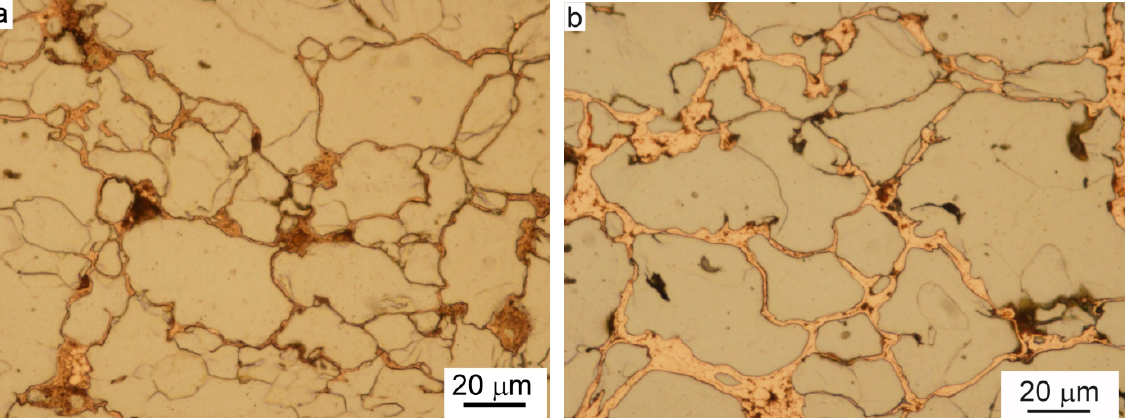
Figure 2. Cross-sections of typical copper-coated iron particles. The content of copper in presented powder is 8 wt.%, LM.